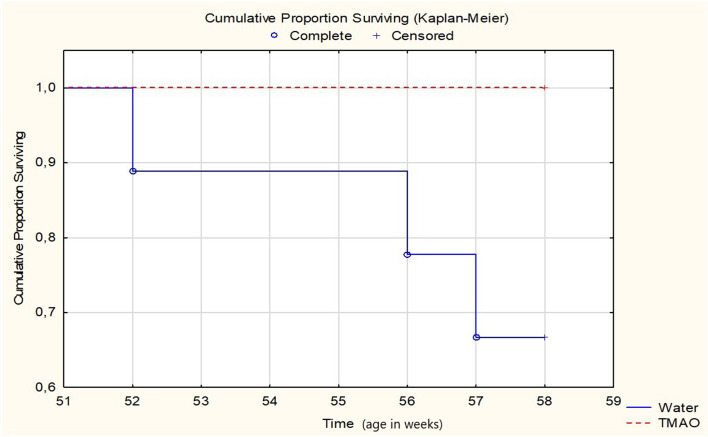
Survival Kaplan-Meier curves for SHHF - Spontaneously Hypertensive Heart Failure (SHHF/MccGmiCrl-Leprcp/Crl) rats drinking either water (control group, n = 9) or TMAO solution (n = 9).Log-Rank test p=0.06555.